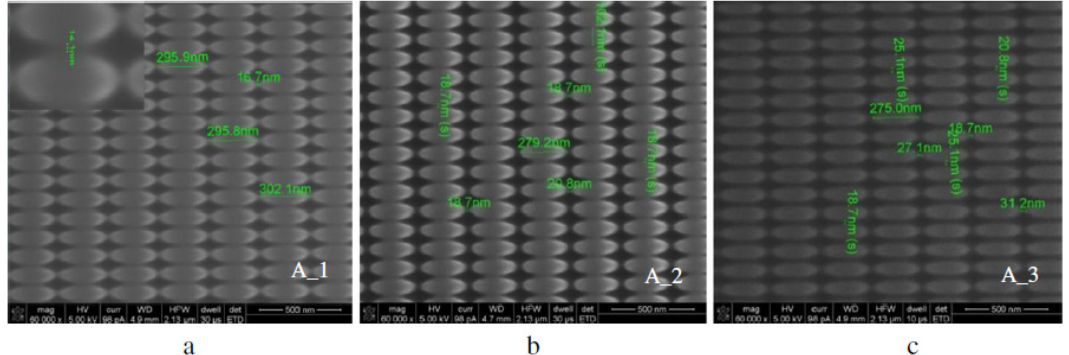
Figure 29. SEM images of elliptical nanostructure on Si substrates. The spacing of the elliptical nanostructure was: ( a ) 15 ± 1 nm, ( b ) 18 ± 1 nm, and ( c ) 22 ± 2 nm for a scale bar of 500 nm. Reprinted with permission of [94].